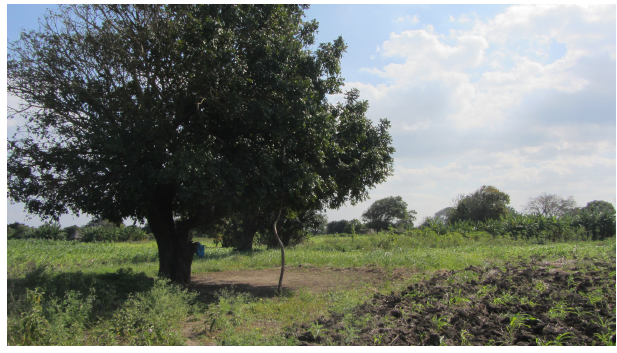
Fig. 3. A tree surrounded by farm